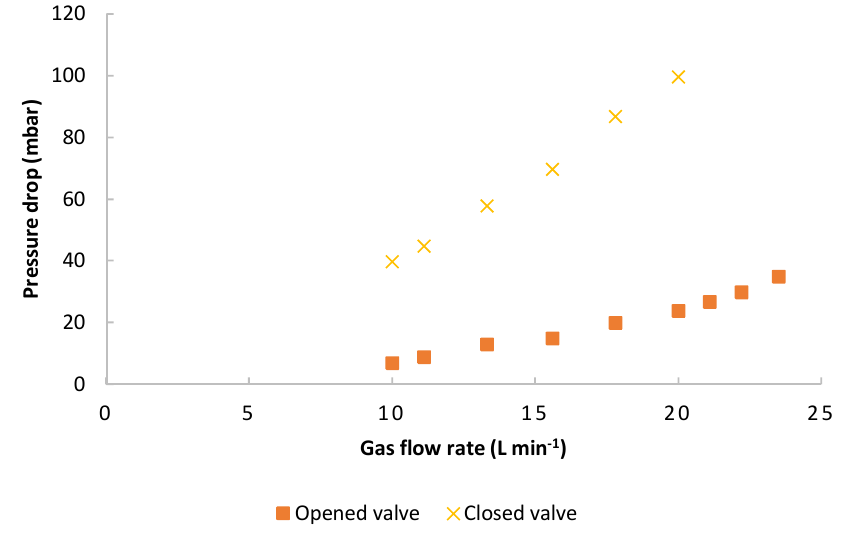
Figure A2. Pressure drop as a function of the gas flow rate for two configurations.